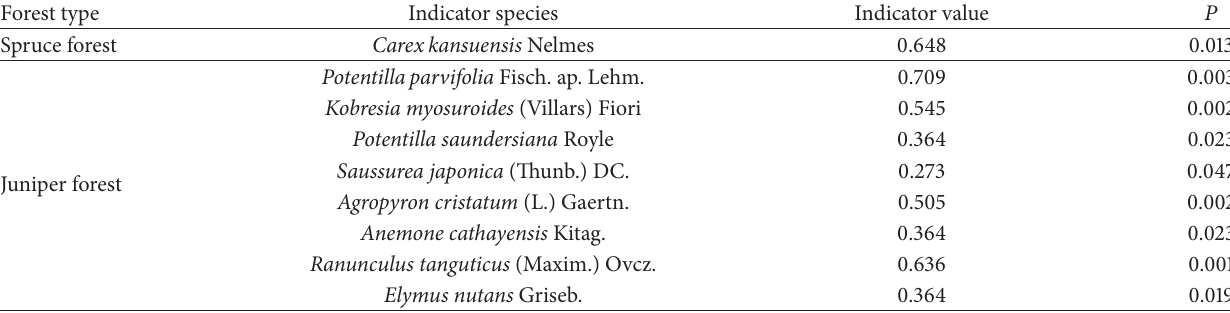
Table 2: Species identified as significant indicators of spruce or juniper coniferous forests, based on indicator species analysis.